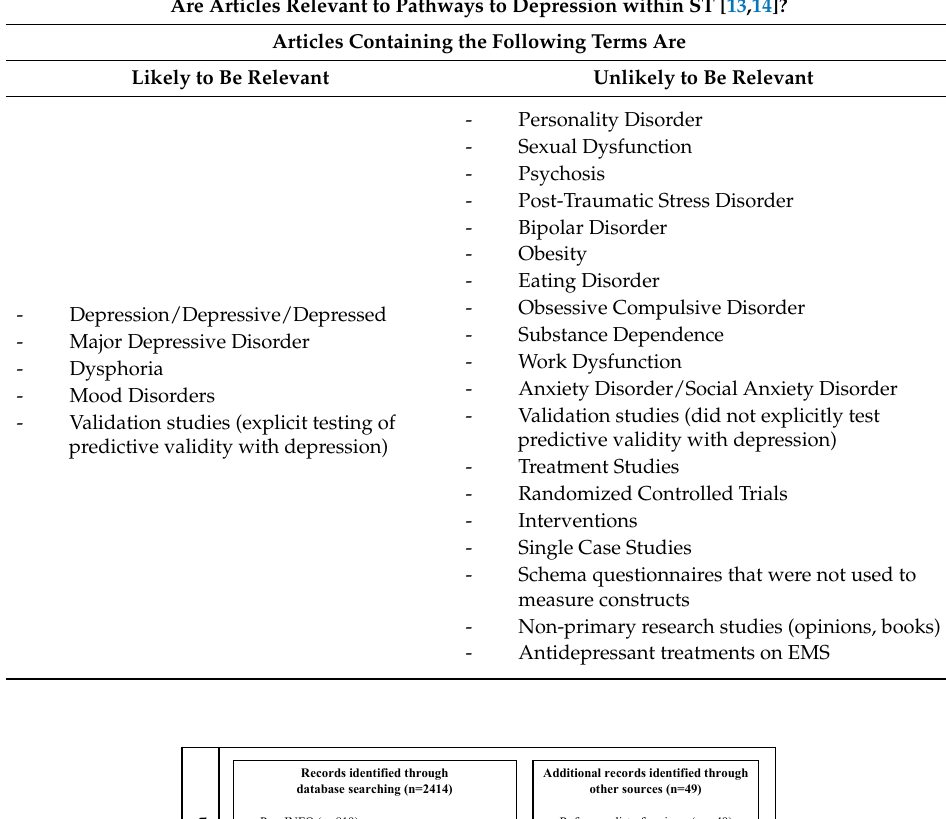
Table 2. Checklist to guide final stage screening for scoping review. Are Articles Relevant to Pathways to Depression within ST [13,14]?